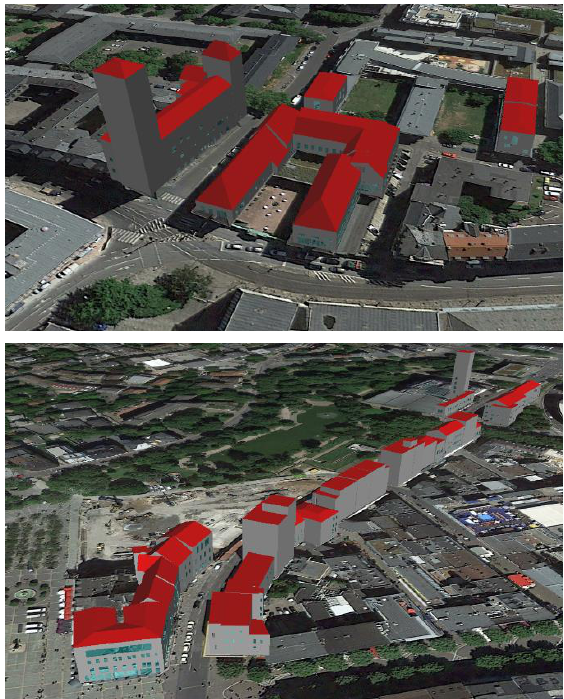
Figure 10. Export of modelled building blocks into Google